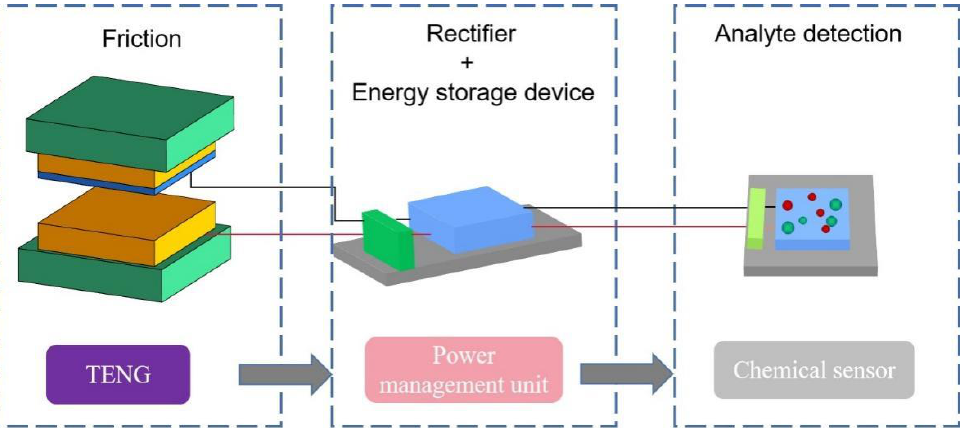
Figure 3. TENG serves as a power source in the TENG-based chemical sensor system.